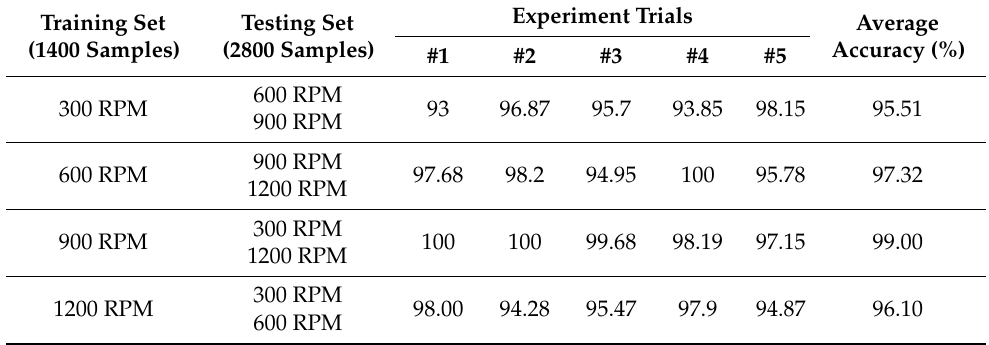
Table 6. Fault classification results of the proposed model obtained during five experimental